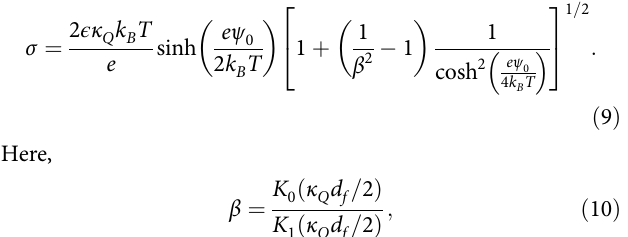
ffiffiffiffiffiffiffiffiffiffiffiffiffiffiffiffiffiffiffiffiffiffiffiffiffi r 0 H x f 0 r 02